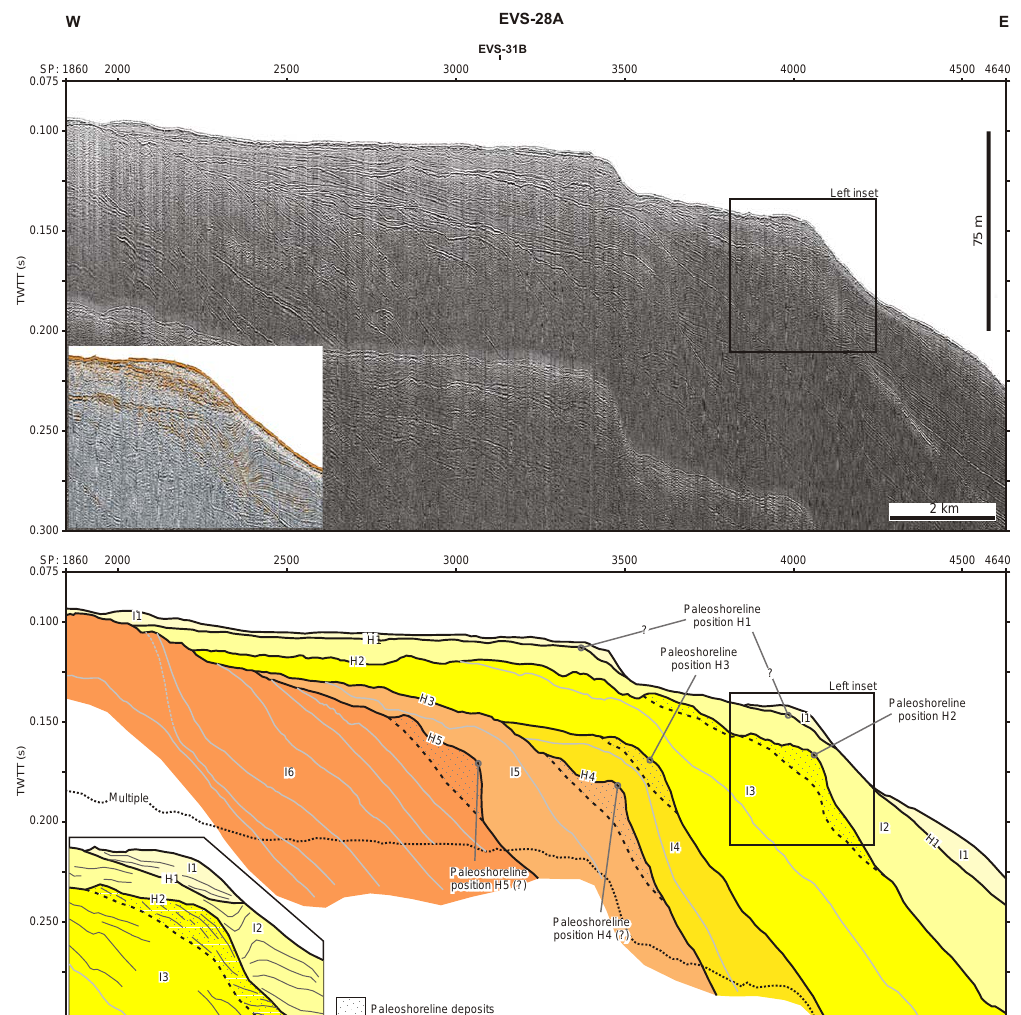
Fig. 7. SCS sparker profile EVS-28A and relative line drawing showing the seismo-stratigraphic units. Note the presence of large erosional surfaces that in some cases end in ancient paleoshorelines indicated by the change in reflector slope and by the probable presence of shoreline deposits (detail in the left inset). These surfaces were used to determine the age of the seismic horizons H1 to H5. See profile location in Fig.